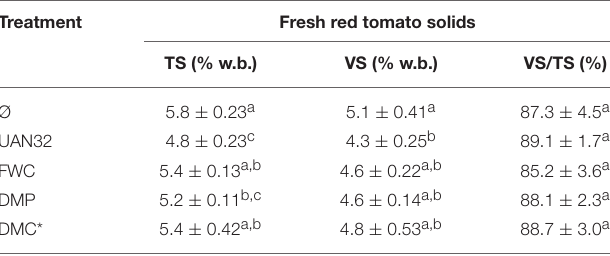
Letter categories represent significance at the α = 0.05 level for each respective measurement category. * Note that the DMC treatment was abandoned after the first fertigation event due to difficulties in applying it due to excessive particle